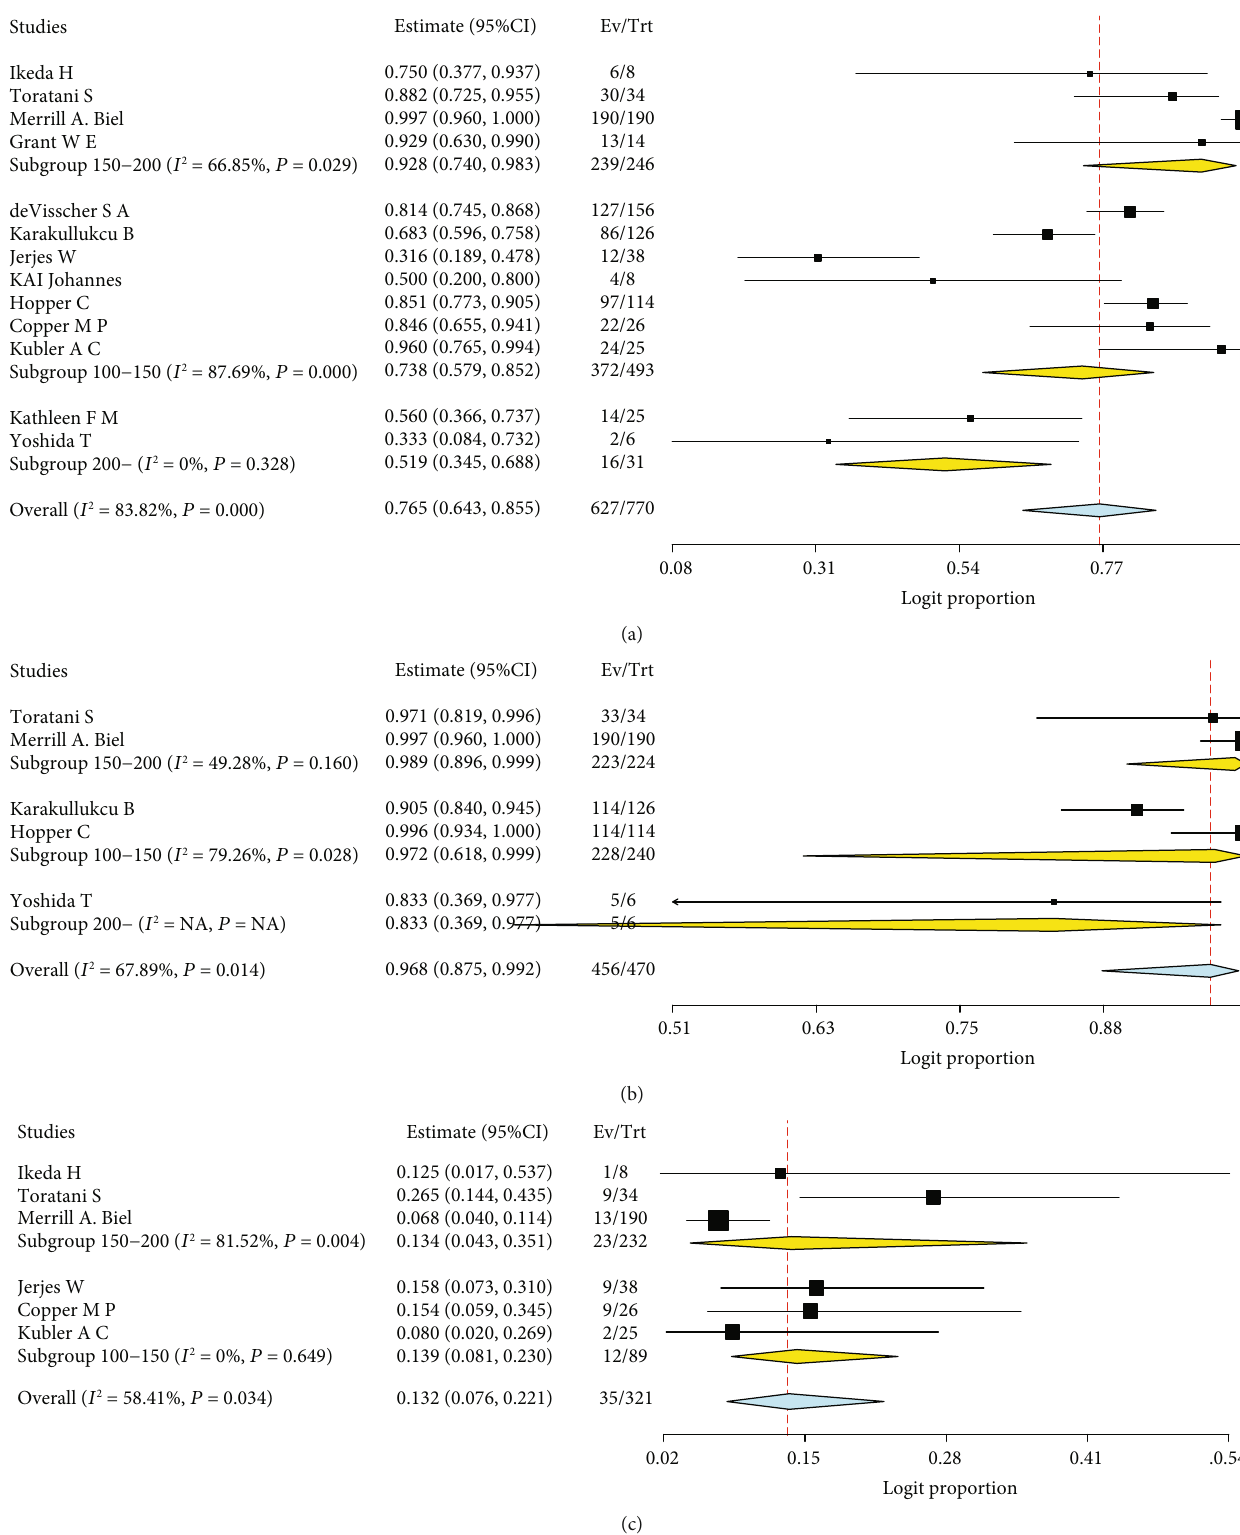
Figure 9: Forest plot of subgroup analysis of (a) CR, (b) OR, and (c) RR in cases using di ff erent power